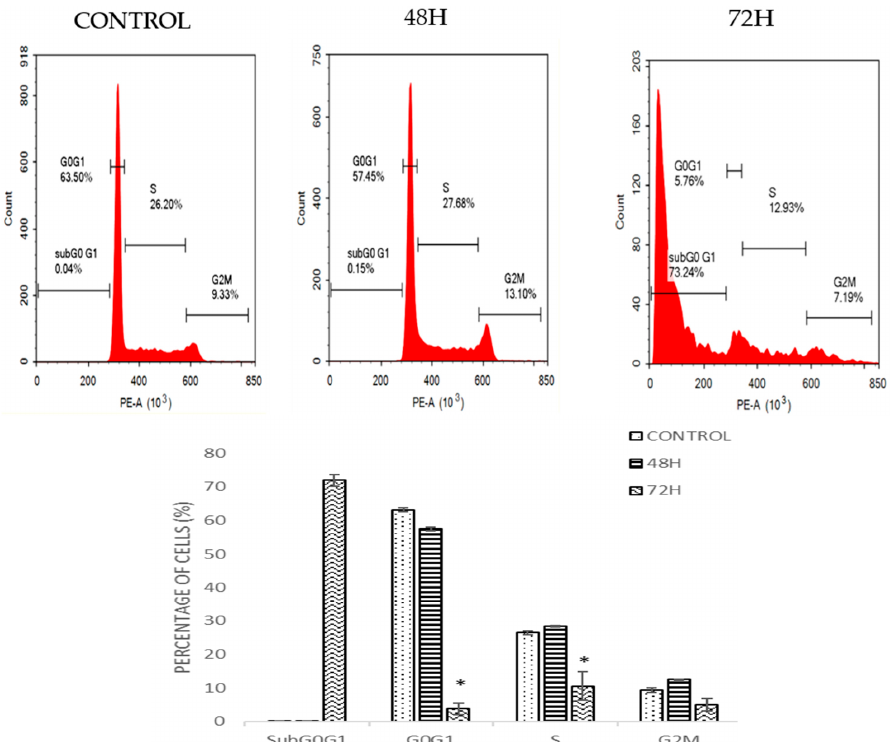
Figure 5. Cell cycle histogram and bar chart analysis for SW620 after being treated with DMCH for two time periods (48 h and 72 h). All data are expressed as mean ± standard error mean (S.E.M.). * p < 0.05 compared with corresponding controls. 2.5. DMCH Induces Changes in the Mitochondrial Membrane Potential in SW620 and HT29 The mitochondrial membrane potential was analysed by staining the cells with JC-1 dye [16]. This dye is a marker that detects the loss of mitochondrial membrane potential [17]. The dye will emit green and red fluorescence in response to mitochondrial depolari- zation. The JC-1 dye present in healthy cells in the form of aggregates emits red fluores- cence, while in apoptotic cells the dye is in monomeric form and emits green fluorescence [15]. The ratio of red to green was analysed. Histogram analysis in Figure 6 and Figure 7 shows the ratio of red/green fluorescence after treatment with DMCH in HT-29 and SW620 for 48 and 72 h. As illustrated in Figure 6 and Figure 7, as the time of treatment increased, the ratio of monomers observed was higher which indicates that apoptosis was induced in HT29 and SW620 cells in a time-dependent manner.